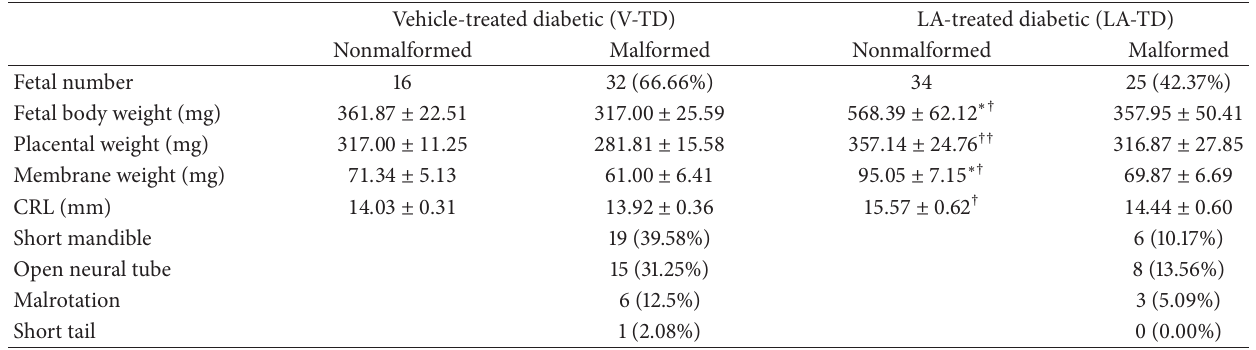
Table 3: Malformations present in the two diabetic groups (vehicle- and LA-treated group).